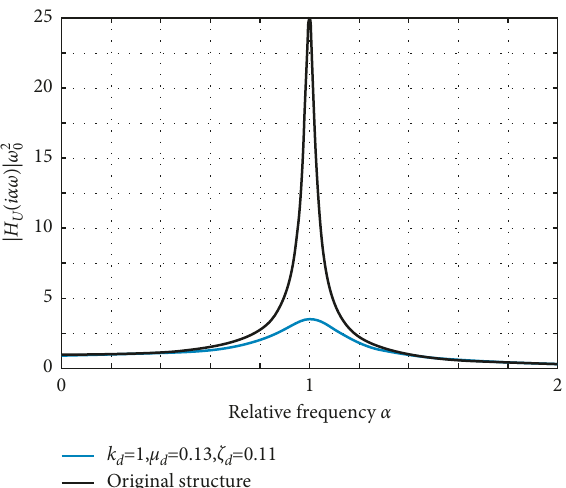
Figure 10: Displacement amplification factor ( κ